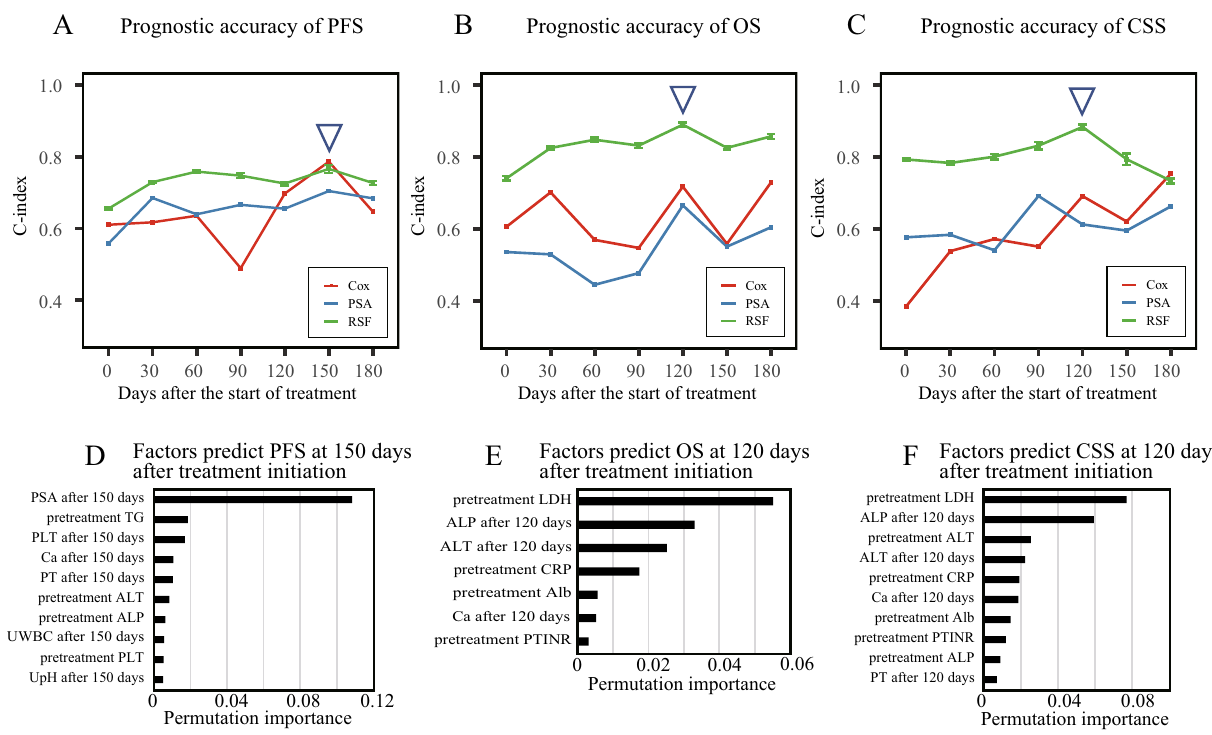
Figure 2. Time-series of prognostic accuracy for patients with metastatic prostate cancer. ( A to C ) Accuracy of prediction of progression ( A ), overall survival ( B ), and cancer specific survival ( C ). The green, red, and blue lines indicate the RSF, Cox proportional hazards, and prognostic PSA-based models, respectively. The triangle mark indicates the time point at which prediction accuracy was the highest for RSF prediction. Error bars represent standard deviations of 10 independent RSF. Permutation importance in prediction of progression at 150 days after treatment initiation ( D ), overall survival at 120 days after treatment initiation ( E ), and cancer- specific survival at 120 days after treatment initiation ( F ). The number of factors was defined as the top 10 factors or those with positive